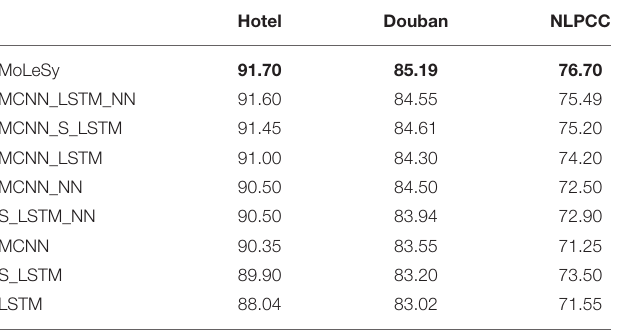
TABLE 3 | The results of ablation experiments.